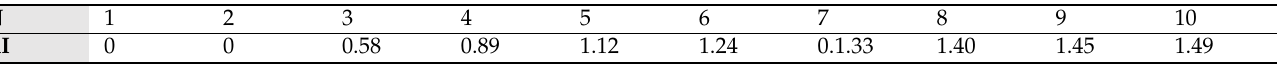
Table 4. The value of the Random Consistency